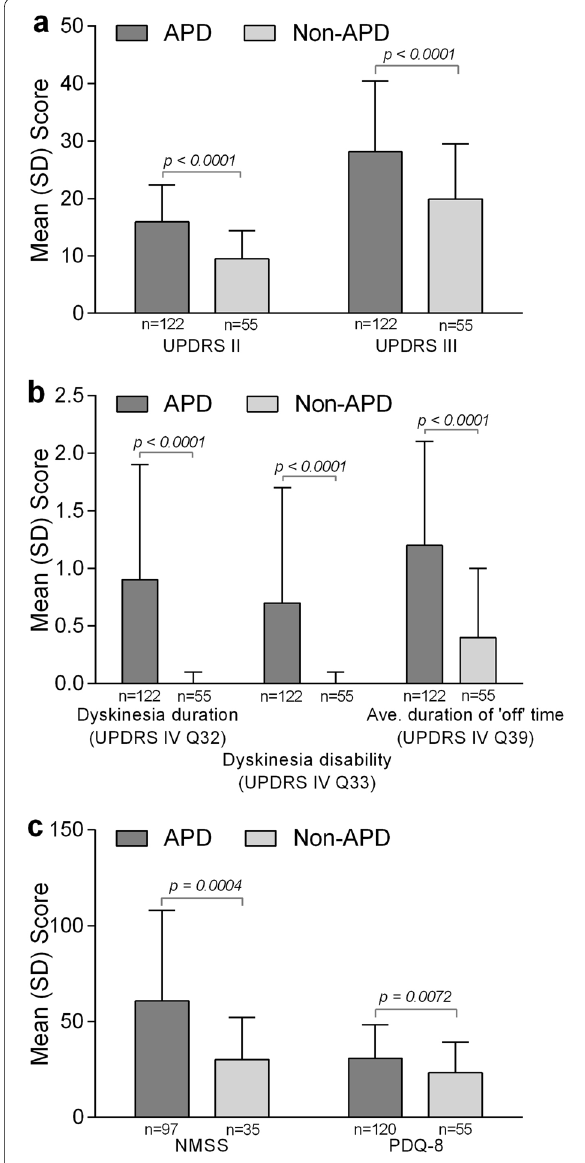
Fig. 1 Disease status and quality of life scores for patients in the APD and non-APD subgroups. Disease status and quality of life scores for patients in the APD and non-APD subgroups as per a UPDRS parts II and III; b UPDRS part IV (dyskinesia duration, dyskinesia disability, and average duration of “off” time); and c the NMSS and PDQ-8. APD, for Parkinson’s Disease; PDQ-8, Parkinson’s Disease Questionnaire; Q,